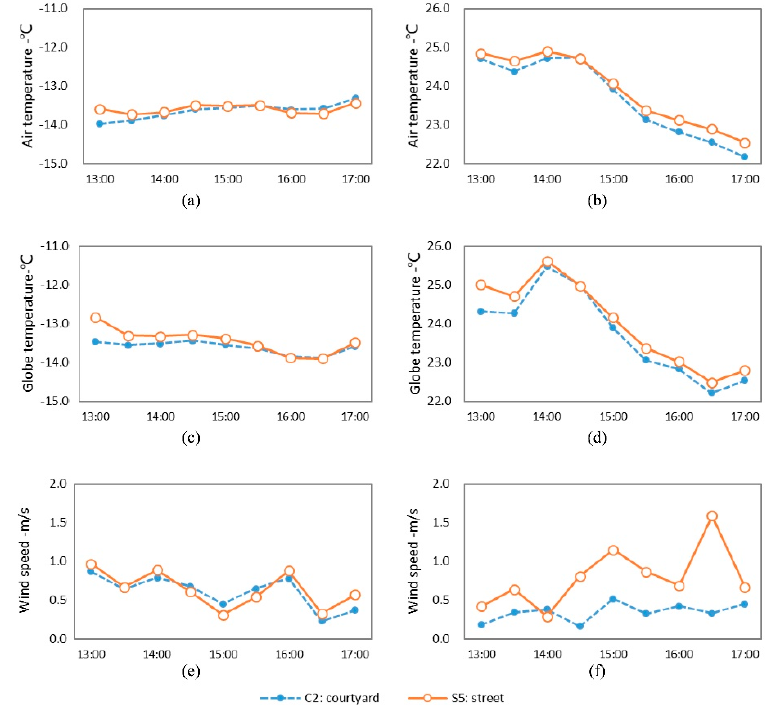
Figure 9. Variation curves of microclimate parameters in the street and courtyard. ( a ) T a in winter; ( b ) T a in summer; ( c ) T g in winter; ( d ) T g in summer; ( e ) wind speed in winter; ( f ) wind speed in summer.